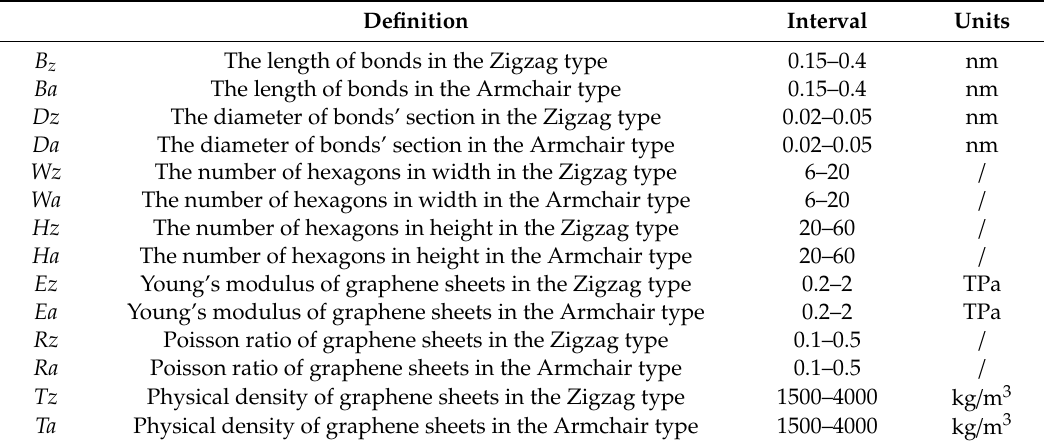
Table 1. Geometrical and material parameters for graphene sheets *.